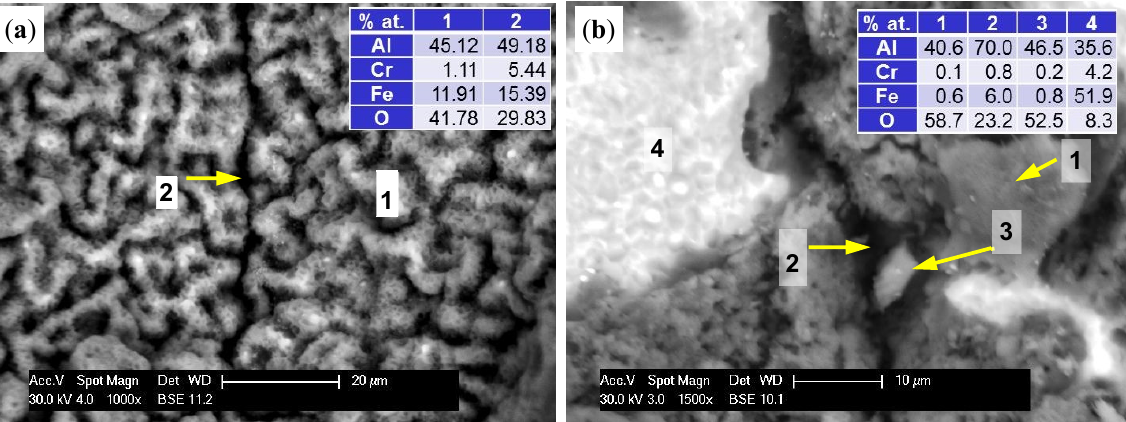
Figure 10. Boundary separation of subsequent layers material of A-sample at 1200 °C/5 h ( a ) and at 1200 °C/50 h ( b ). 1—surface (spall); 2—boundary (spall); 3—chip; 4—the exposed surface of the sample (base and